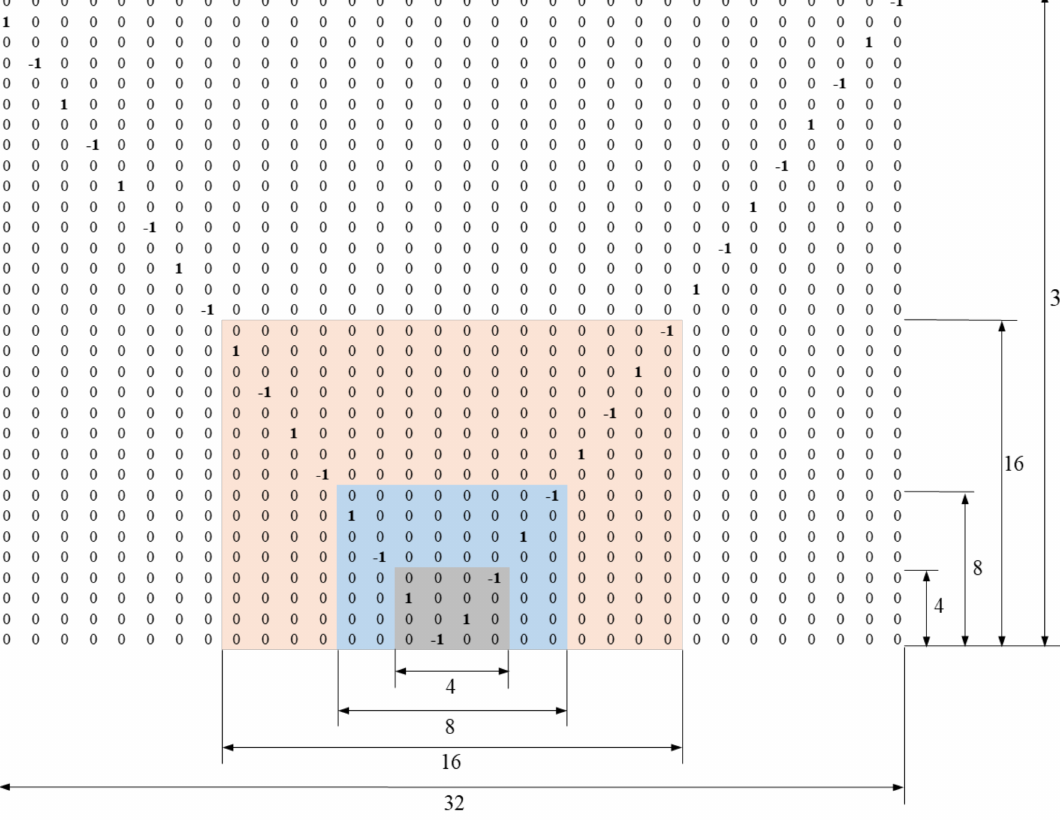
Figure 11. An example of 32 − point permutation matrix ( G